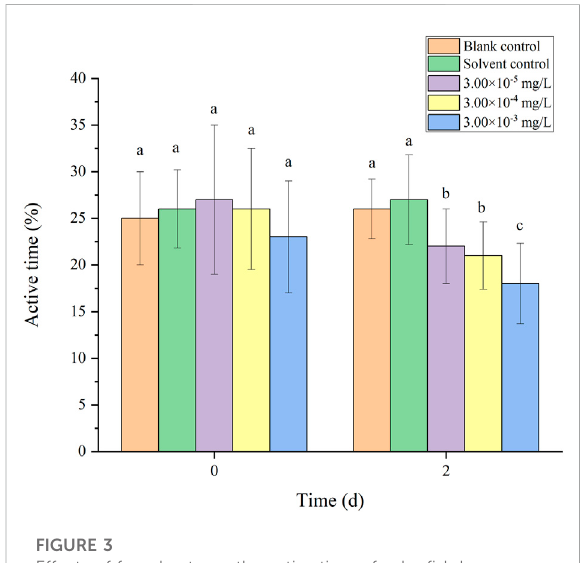
FIGURE 3 Effects of fenvalerate on the active time of zebra fi sh larvae locomotion.